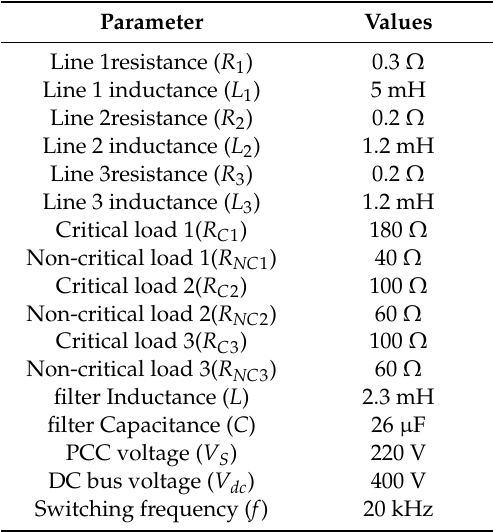
Figure 8. MATLAB / Simulink platform for microgrid with three ES-2. Figure 8. MATLAB/Simulink platform for microgrid with three ES-2. Table 1. Parameters for the case study of an ES Table 1. Parameters for the case study of an ES system.